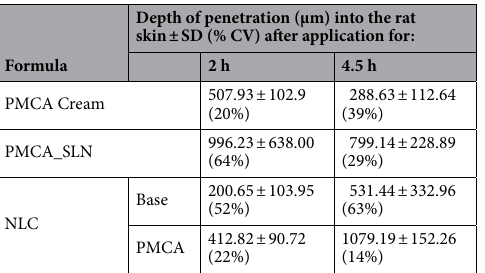
Depth of penetration (µm) into the rat skin ± SD (% CV) after application for: Formula 2